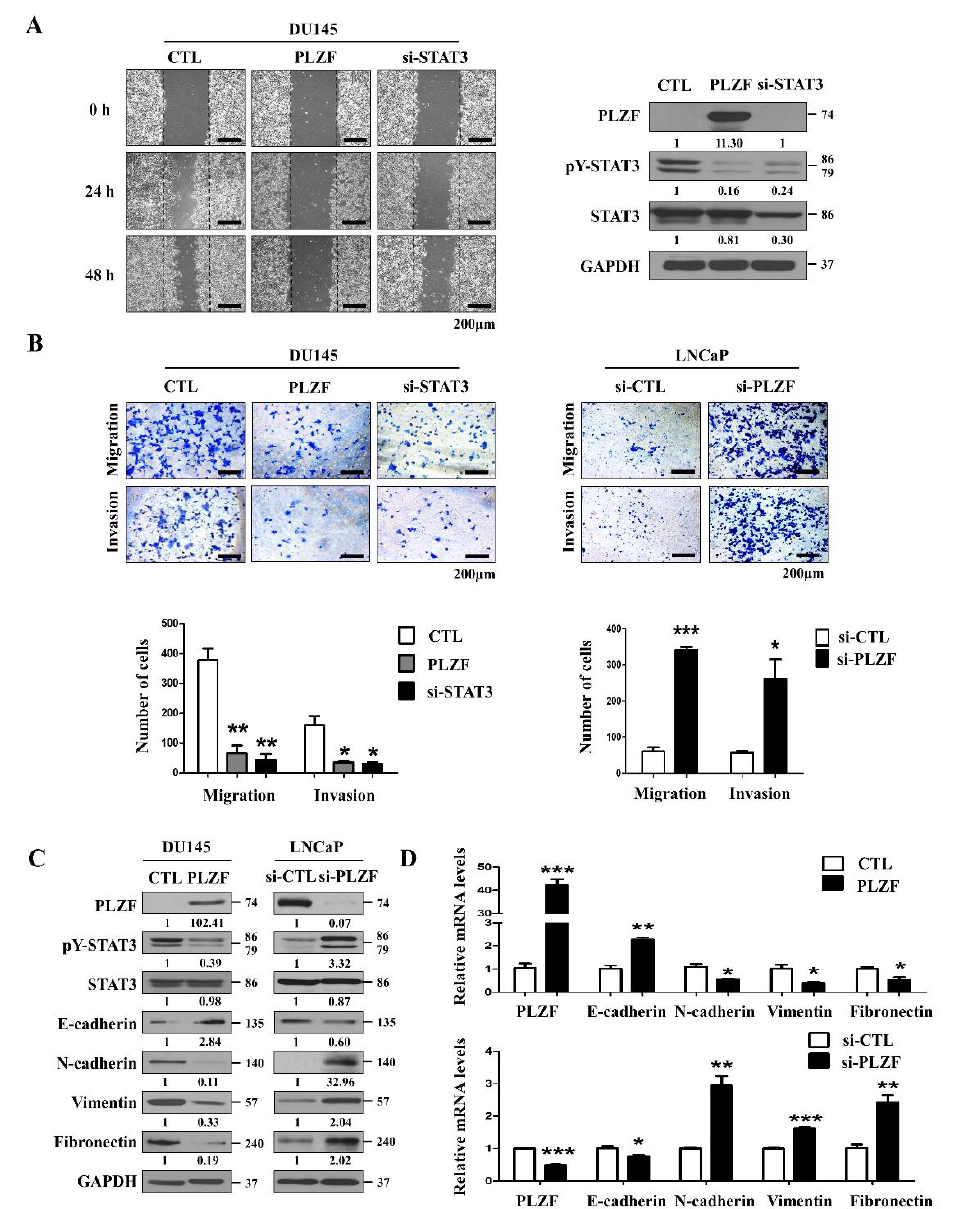
Figure 3. PLZF ablation in prostate cancer promotes cell migration and invasion via activation of STAT3. ( A ) Wound healing assay (left) and Western blotting (right) was conducted in PLZF plasmid and siSTAT3-transfected DU145 cells. ( B ) Transwell migration and Matrigel invasion assays were conducted in MOCK- / PLZF- / siSTAT3- and siNT- / siPLZF-transfected cells. The relative cell numbers are shown (bottom). ( C ) Protein expression of the epithelial / mesenchymal related markers were compared by Western blotting in MOCK- / PLZF-transfected cells and siNT- / siPLZF-transfected cells. ( D ) mRNA expression levels of epithelial / mesenchymal related markers were examined by qRT-PCR in DU145 and LNCaP cells transfected with PLZF plasmid and siRNA. In (A) and (B) representative images from three independent experiments were quantified as the mean ± SD; * p < 0.05, ** p < 0.01, *** p <